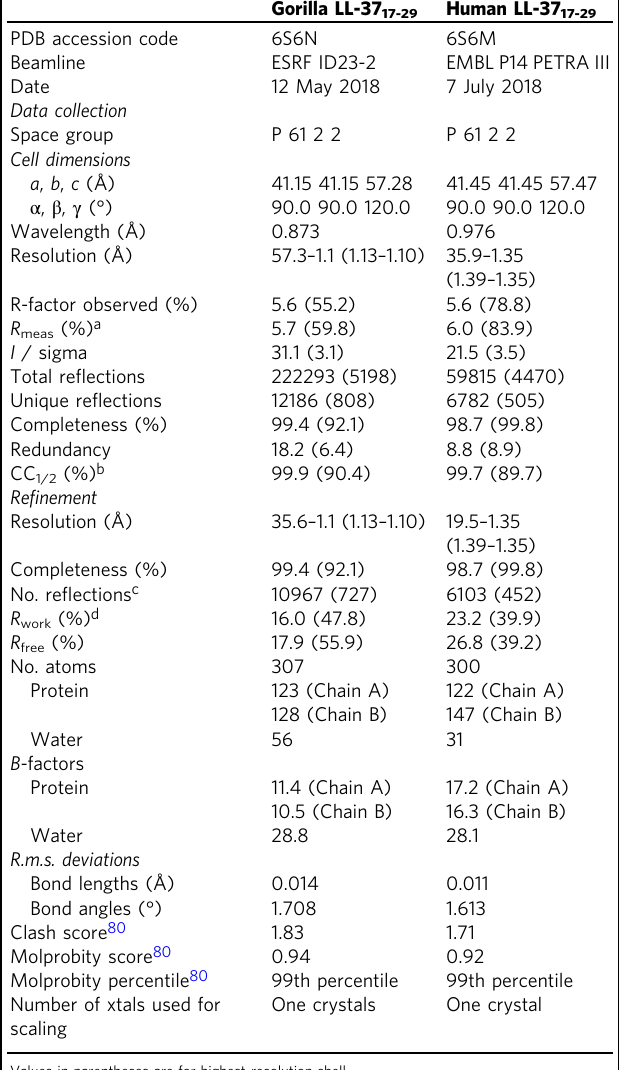
Table 1 Data collection and re fi nement statistics (molecular